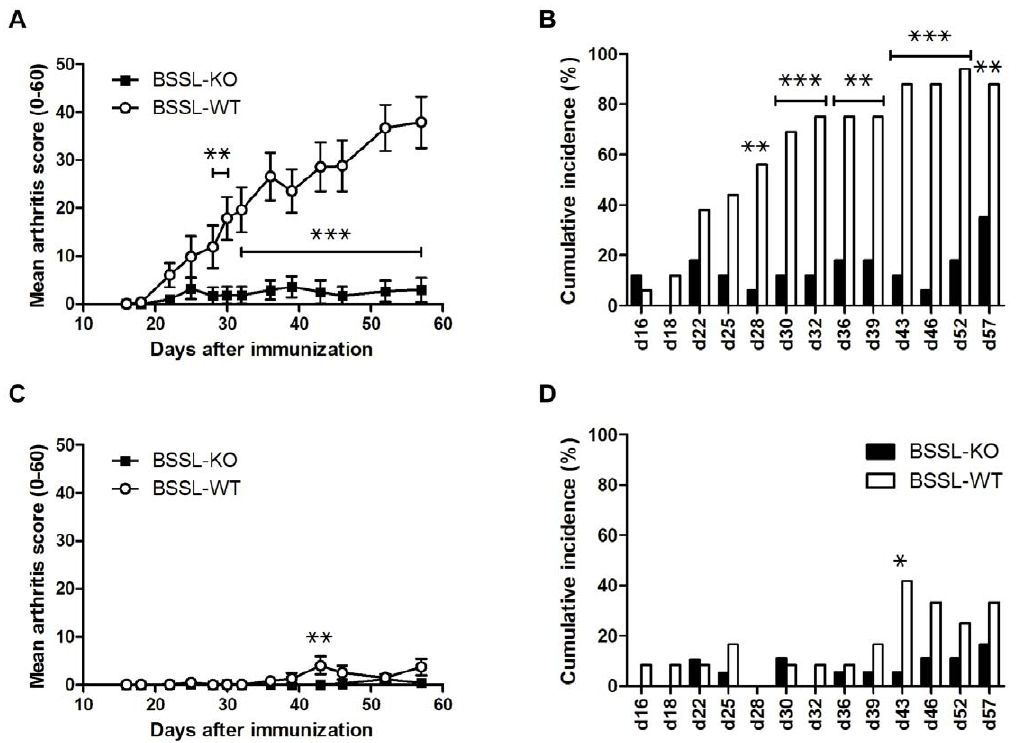
Figure 1. Collagen-induced arthritis in BSSL-KO and BSSL-WT mice. Littermates of BSSL-KO and BSSL-WT mice were immunized with rat collagen type II (CII) on day 0 and boosted on day 21. Arthritis development was followed by blinded clinical scoring 2–3 times per week for 57 days after the initial CII injection. Mean clinical score of arthritis severity in (A) male mice and (C) female mice and the cumulative incidence of arthritis presented as percentage of affected mice with clinical score $ 1 in (B) male mice and (D) female mice are shown. Error bars indicate 6 SEM. ?? ??? =p , 0.05; ??? =p , 0.01; ??? =p , 0.001.